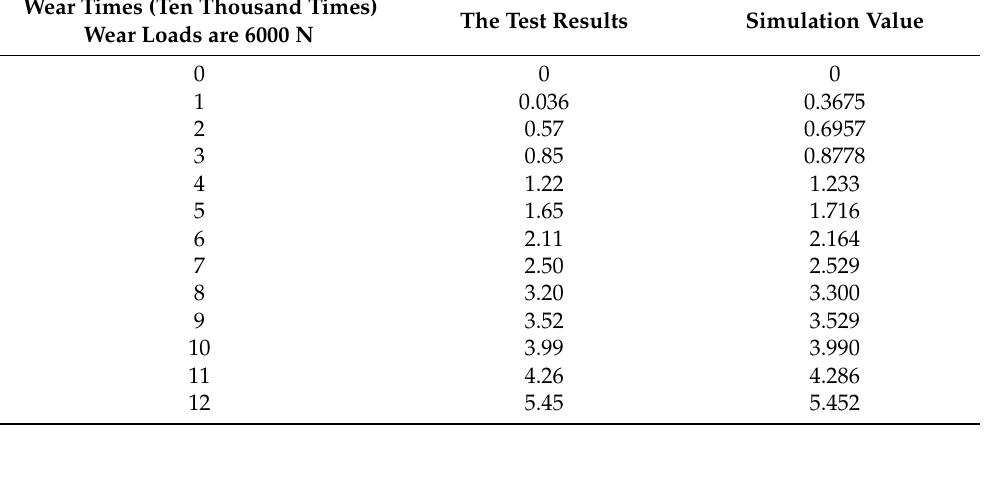
Table 6. Comparison of simulated and experimental values with the number of wear at 6000 N.